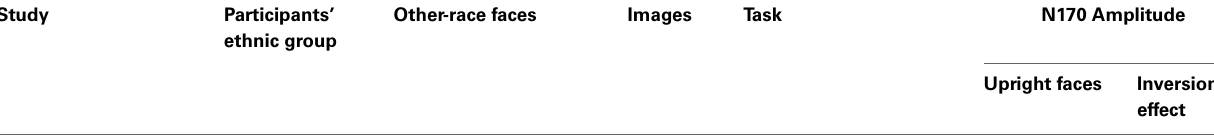
Table 1 | Previous studies on N170 ethnicity effects, sorted by task